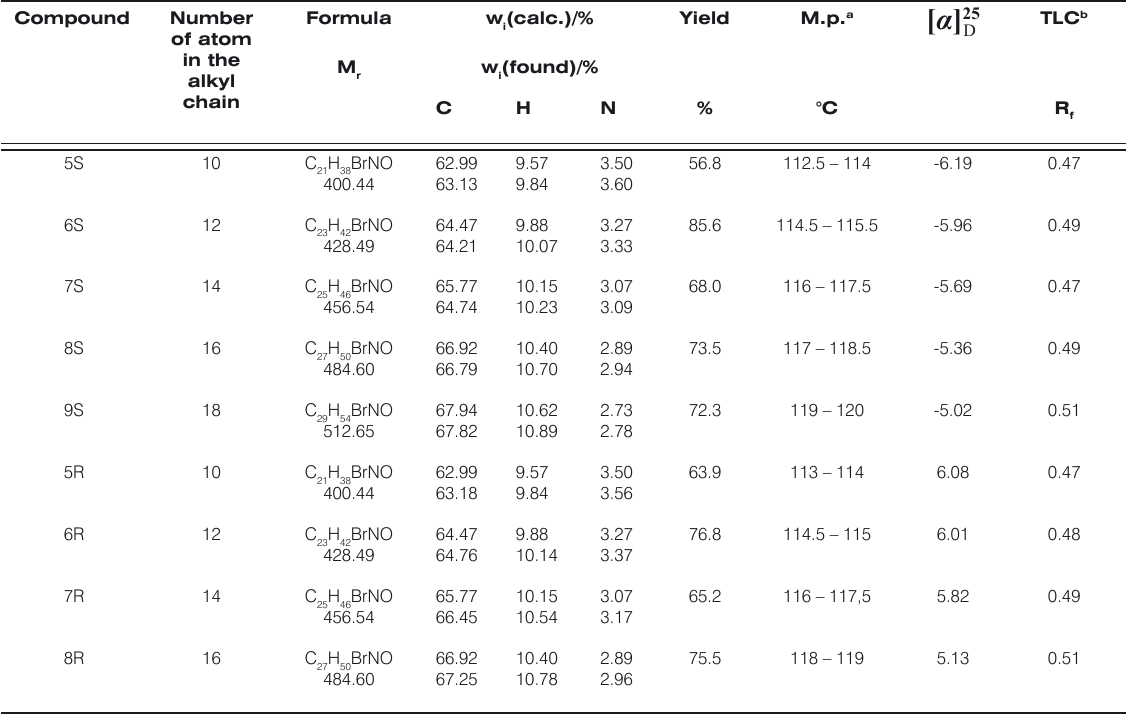
Table 1. Yields and physicochemical properties of prepared